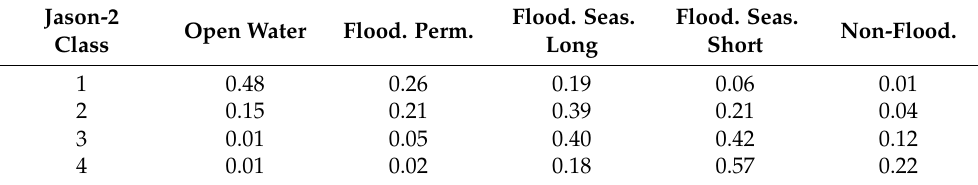
Table A4. Confusion matrix between 4 classes of RA backscattering coefficients from Jason-2 and the 5 land type classes identified on the study